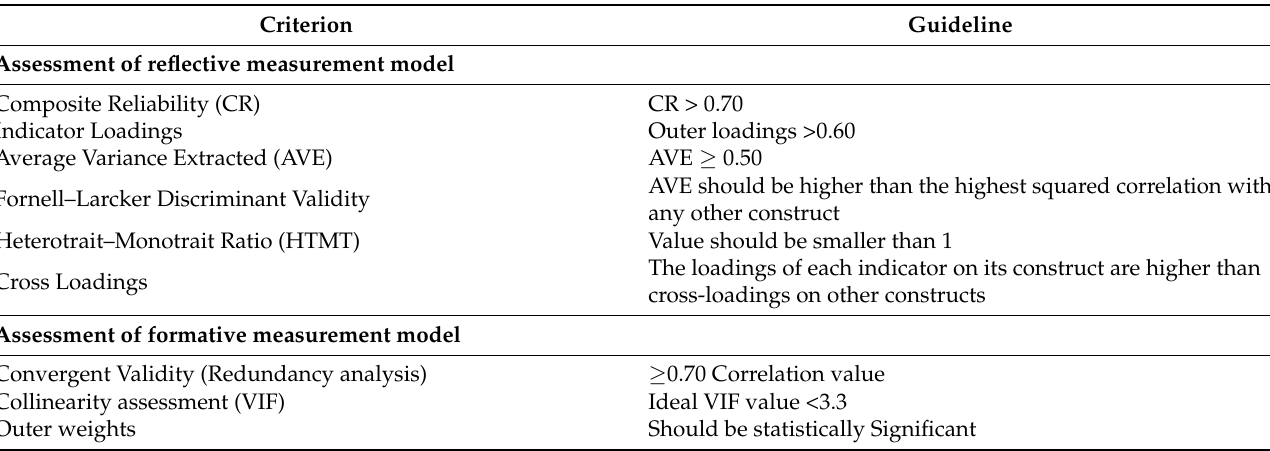
Table 6. Assessment of measurement models.